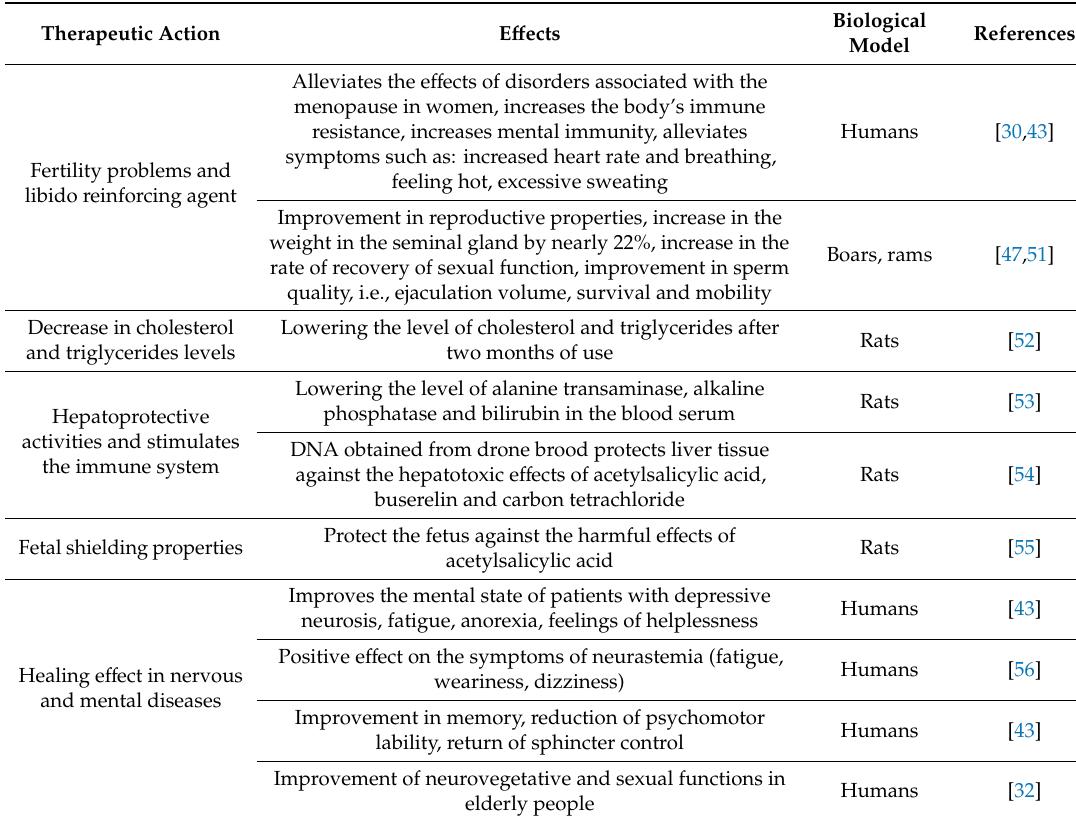
Table 4. Scientific research focused on the use of drone brood in the treatment of various health